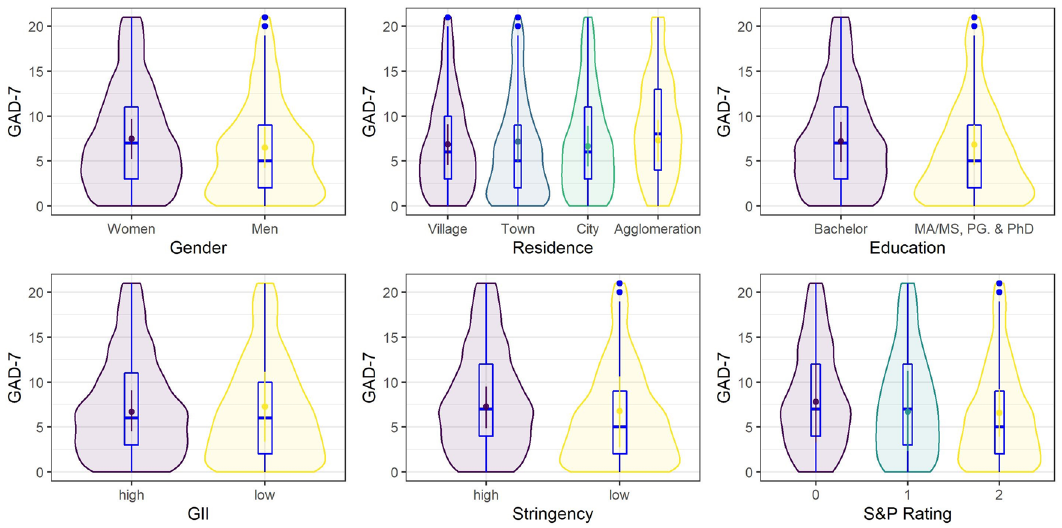
Figure 3. Posterior means of predicted marginal means (points) with 95% credible intervals (vertical lines) from the Bayesian skew-normal multilevel model for generalized anxiety (GAD-7) scores. Boxplots and violin plots show the distribution of the data.